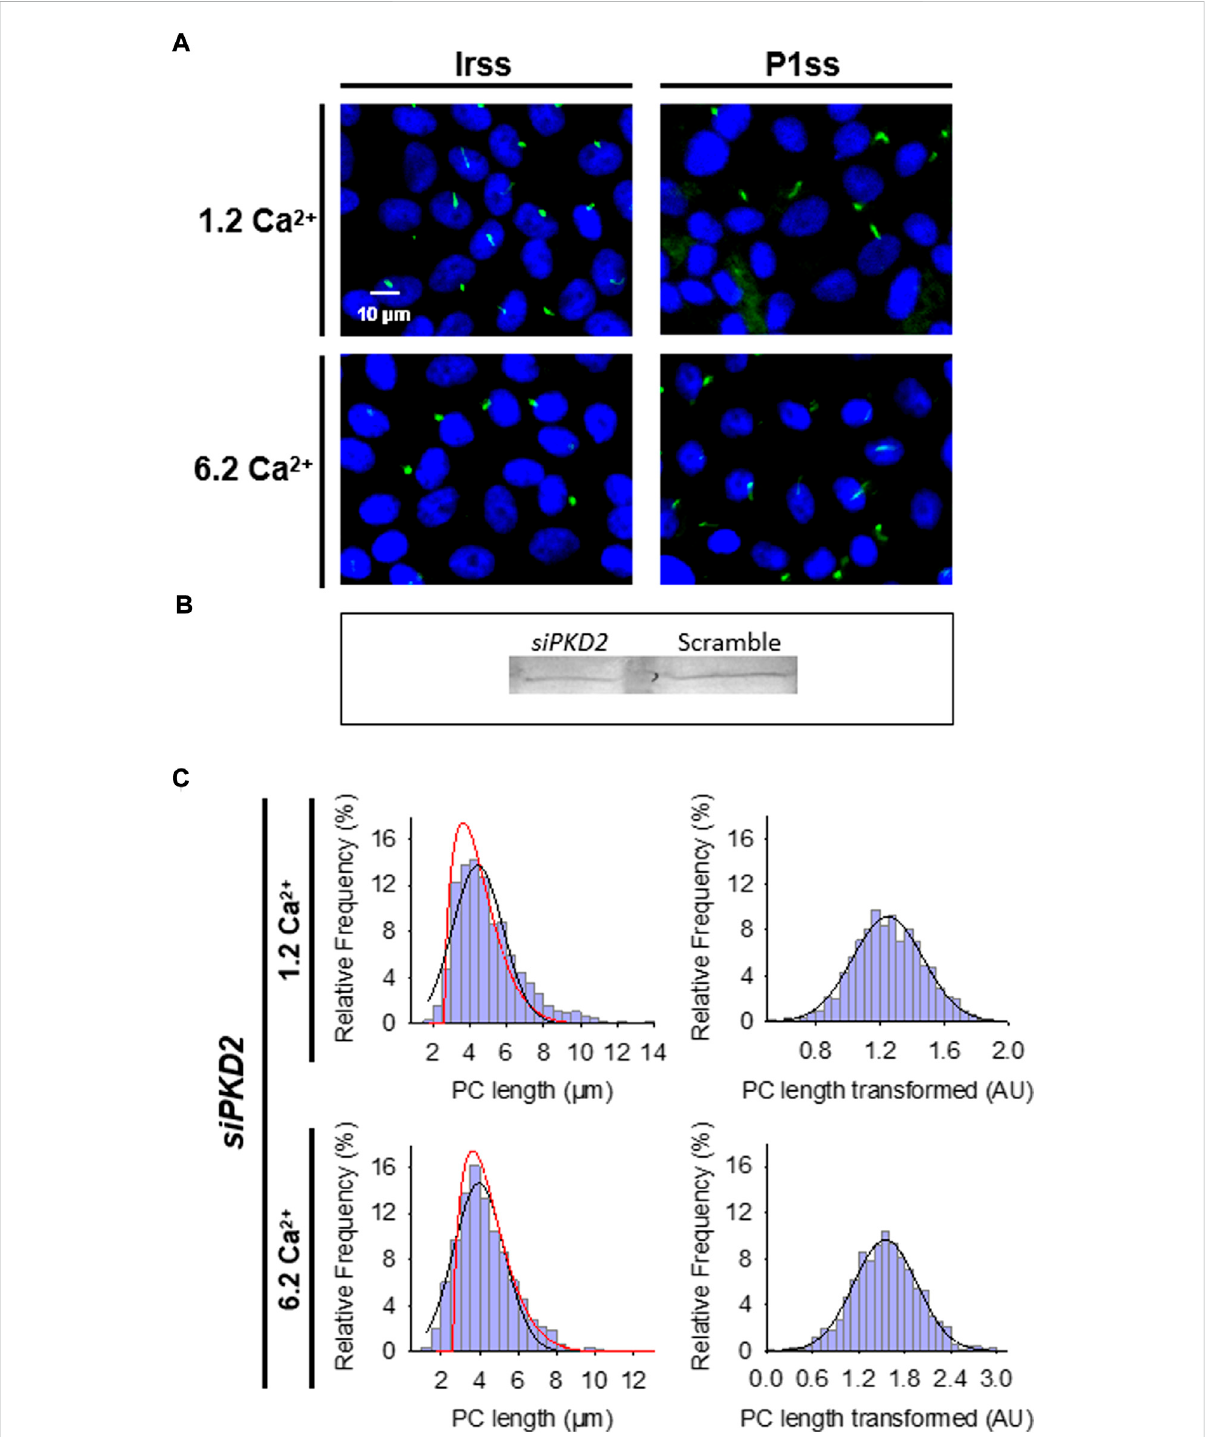
Effect of PKD2 gene silencing on the primary cilium length of wild-type LLC-PK1 cells. (A) Primary cilia are observed in green (FITC) and nuclei stained in blue (DAPI) in cells transfected with scrambled (Irss) and PKD2-speci fi c (P1ss) probes in either normal (1.2 mM) or high Ca 2+ (6.2 mM) conditions. In normal Ca 2+ , P1ss silenced cells had longer primary cilia than their respective controls (Irss, 1.2 Ca). Longer primary cilia were also observed in silenced P1ss cells in high Ca 2+ respect to Irss, 6.2 Ca condition. (B) Western blotting conducted with scrambled and speci fi c PC2 siRNA. (C) Box-Cox transformation for data ofthe primary cilium length in LLC-PK1 cells after inhibition of PKD2 gene expression under1.2 mM (Top) and 6.2 mM (Bottom) external Ca 2+ conditions. Frequency data distributions are shown before (Left) and after (Right) Box-Cox transformation. Red lines indicate control